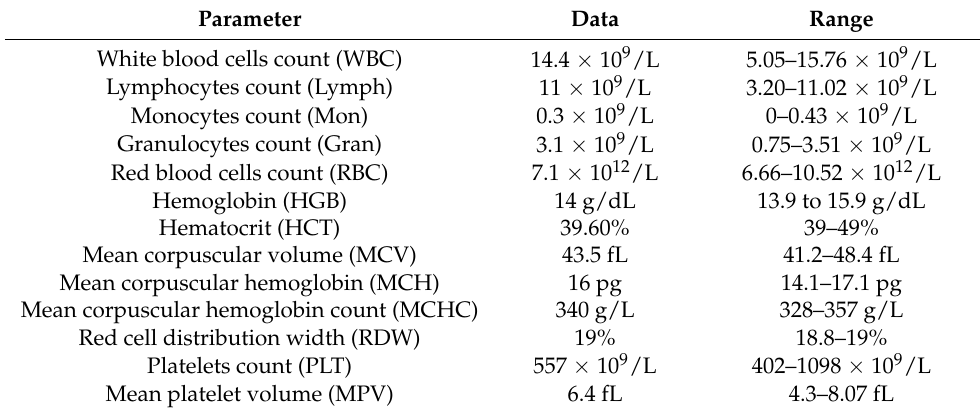
Table 3. Haematological data taken from male mice, representative of the 2nd group. Parameter Data Range White blood cells count